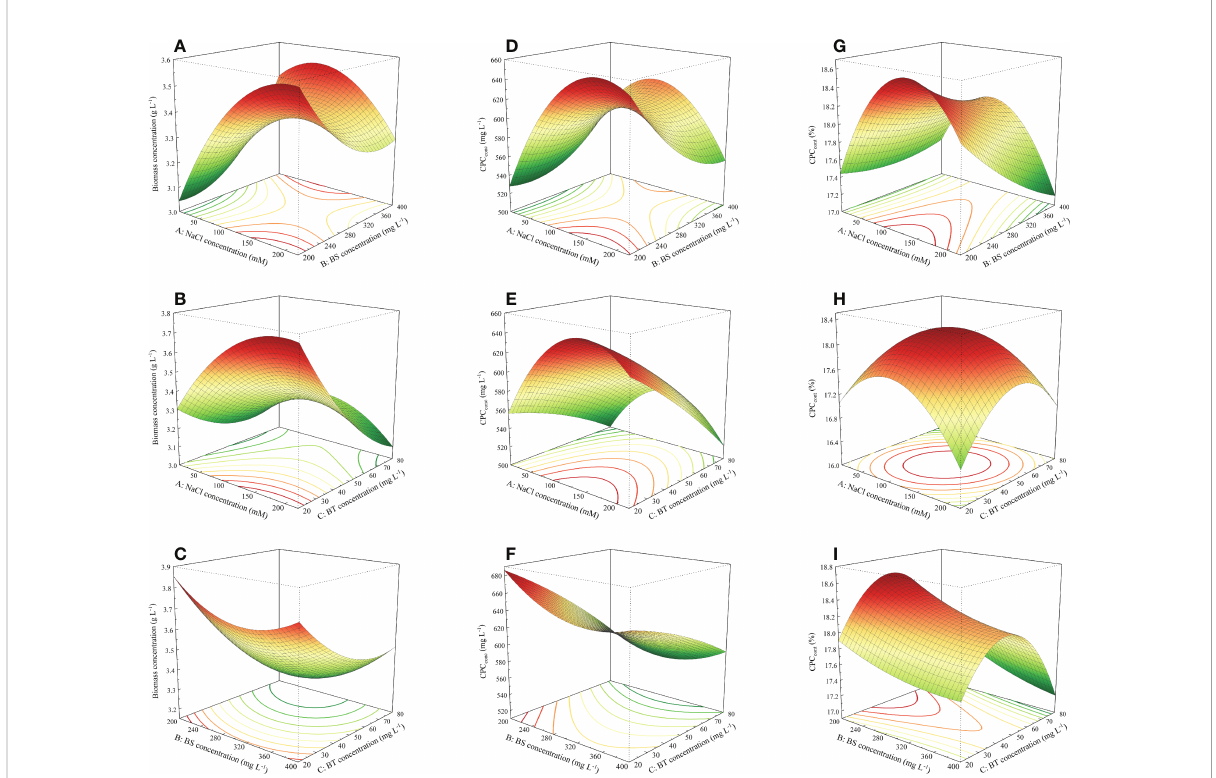
FIGURE 2 Response surface plots visualizing the interactive effects among the NaCl, BS and BT concentration for responses. (A – C) biomass concentration, (D – F) CPC conc , and (G – I) CPC cont